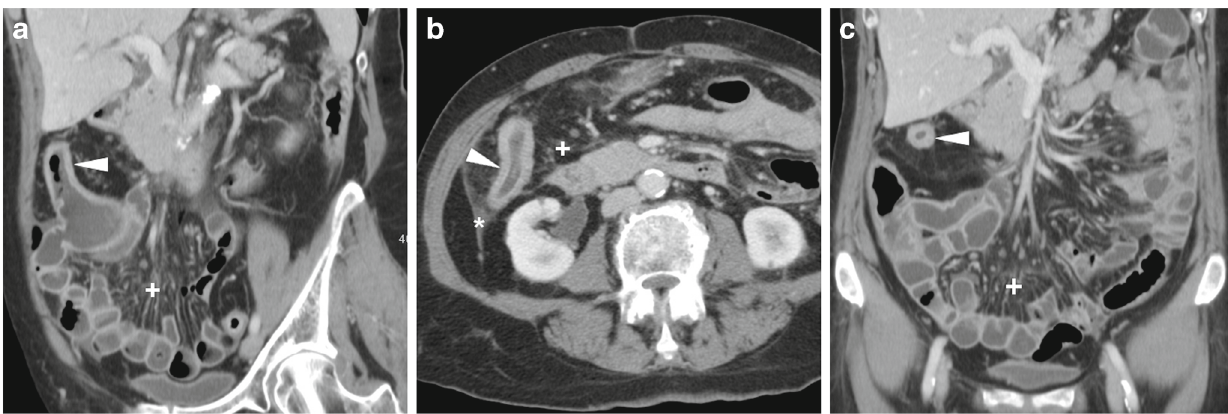
Fig. 12 Serosal and intramural neoplastic recurrence in a 74-year-old female with a history of left hemicolectomy for G3 signet-ring colon carcinoma. Corresponding to an endoscopically impassable stricture, WE-MDCT ( a – c ) showed a poorly distended segment with thickened